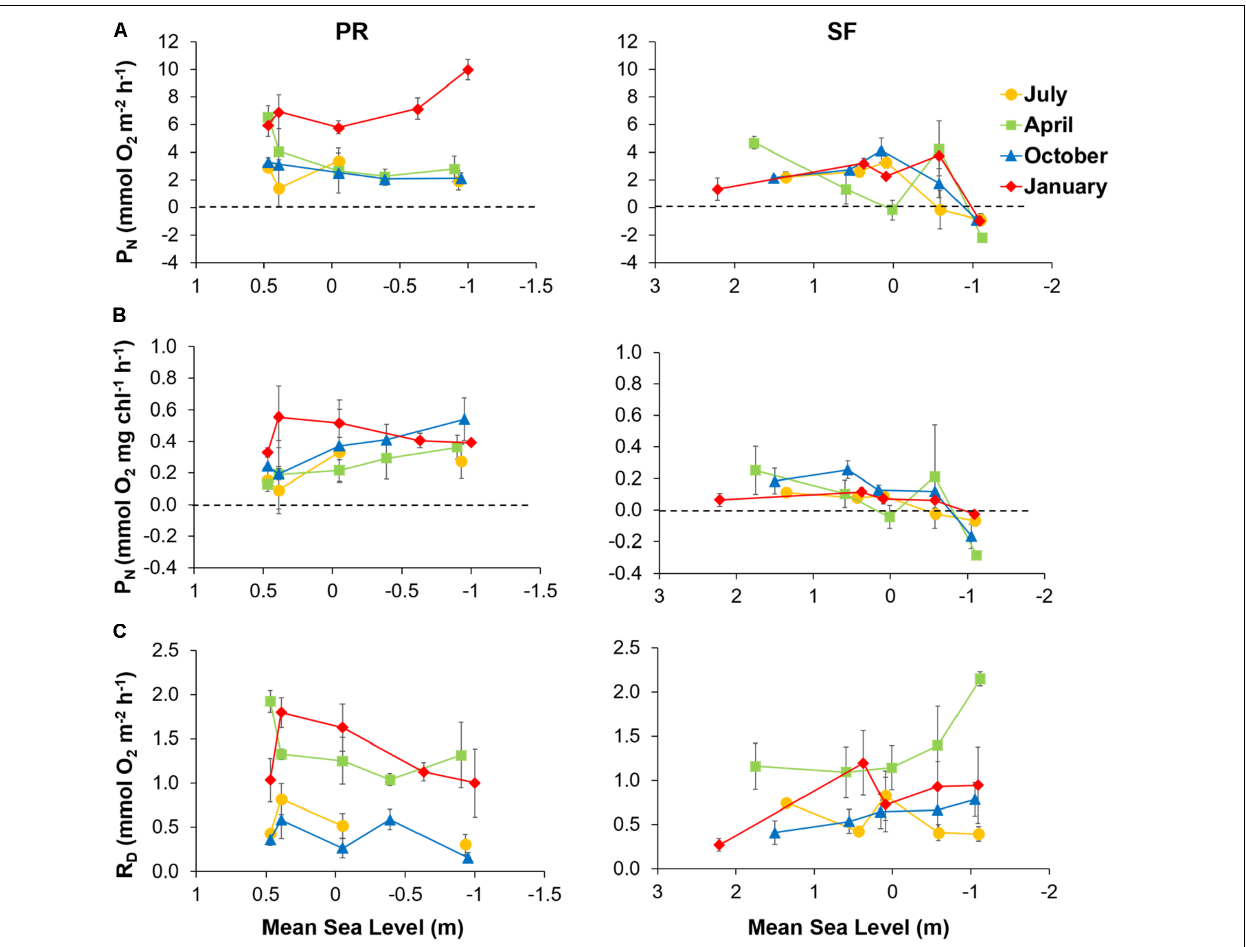
FIGURE 5 | (A) Net production in the photic layer (P N ), (B) respiration in darkness (R D ), and (C) P N normalized by MPB biomass plotted against mean sea level (MSL) along the Puerto Real (PR) and San Fernando (SF) transects in July (yellow), April (green), October (blue), and January (red). Values represent means ± SE ( n =